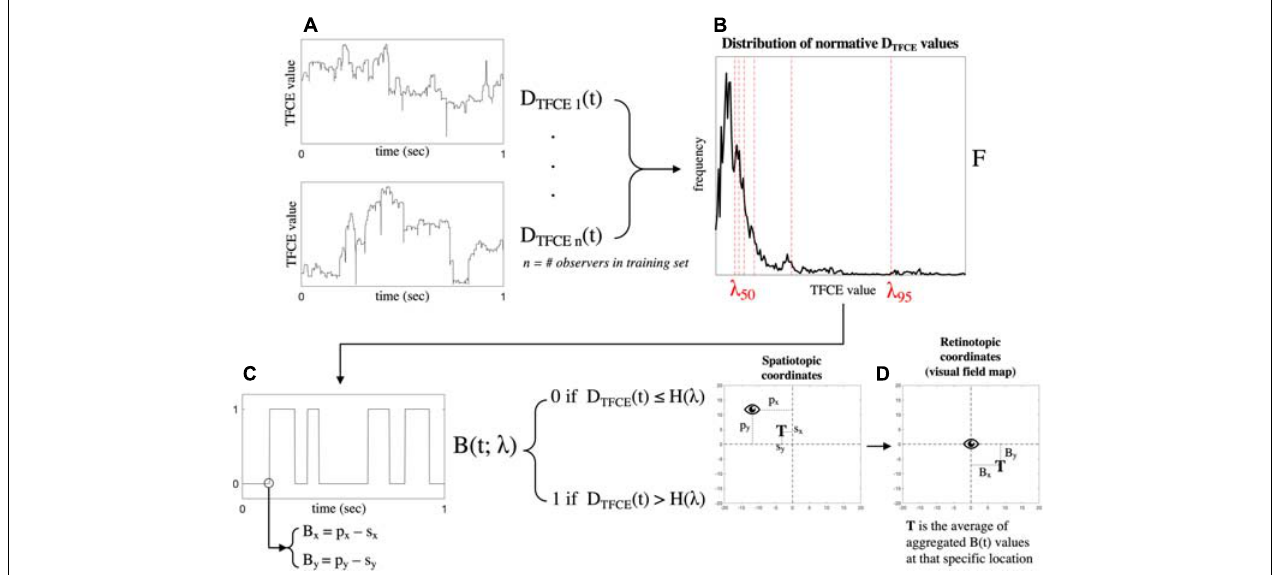
FIGURE 5 | Schematic representation of the algorithm pipeline. Starting from the TFCE-filtered time-series in panel (A) , a probability distribution F of all possible normative TFCE values is computed in panel (B) . For all percentiles λ n of the distribution F , a threshold value F ( λ n ) is defined and used to binarize the TFCE-filtered signal in panel (C) . Each time point of the TFCE-filtered signal has associated with it the spatiotopic coordinates of gaze ( p x and p y ) and the stimulus positions ( s x and s y ), which are converted into retinotopic coordinates B x and B y . The resulting mapped retinotopic coordinates in panel (D) are associated with a target location T which contains the average of the aggregated B ( t ) values at that specific location. B ( t ) is the expected probability that that specific location is affected by a scotoma. An analogous back-projection algorithm is implemented for the reconstruction of the visual field using the recurrent neural network (RNN), where the binarized time-series in panel (C) is defined by the output of the model instead of the threshold F ( λ n